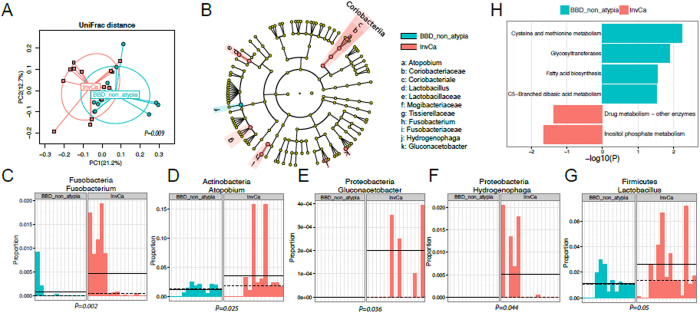
The microbiota of breast tissue adjacent to invasive cancer is distinguishable from that adjacent to benign disease (BBD-non-atypia).(A) Ordination plot based on unweighted UniFrac distance shows the clustering pattern of the breast tissue microbiota between the two disease states. (B) Differential taxa between the breast tissue microbiota of malignant and benign states based on a permutation test. Taxa with a nominal p value < 0.05 are highlighted on the cladogram with red and blue indicating increase and decrease in invasive cancer respectively. (C–G) Barplots show the abundances of the five differential genera between the two disease states. Each bar represents a sample. (H) The differential KEGG pathways with a nominal p value < 0.05 between the microbiota of the two states as revealed by PIRCRUSt analysis.